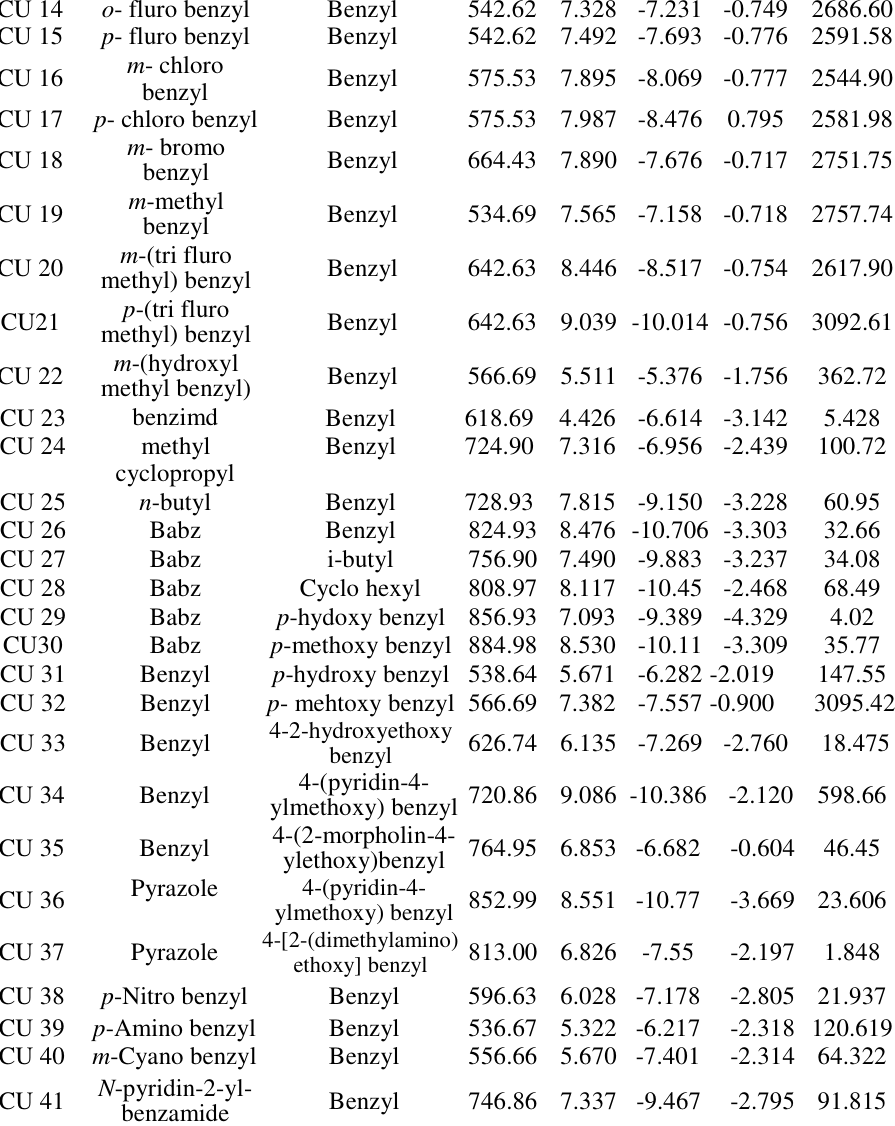
The compound CU 23 the best molecule in the series with Ki < 0.01 nM had Pmdck value (5.428) and Log BB value (-3.192) less than required. The best docked compound from the series CU 37, CU 29 and CU 26 with combined docking scores -66.81, -66.74 and -66.2 respectively (Combined dock scores are provided in Table 2) which had good biological activity (Ki in nM range) had high molecular weight, their Log Po/w (6.826, 7.093 and 8.476 respectively) and Log S (-7.55, - 9.389 and -10.706 respectively) value were not in the acceptable range. The Pmdck value for CU 37 and CU 29 were also very low, lesser than the acceptable range (1.848 and 4.02). The inhibitors CU 30, CU41, and CU 36 which have good biological activity were also having the lesser